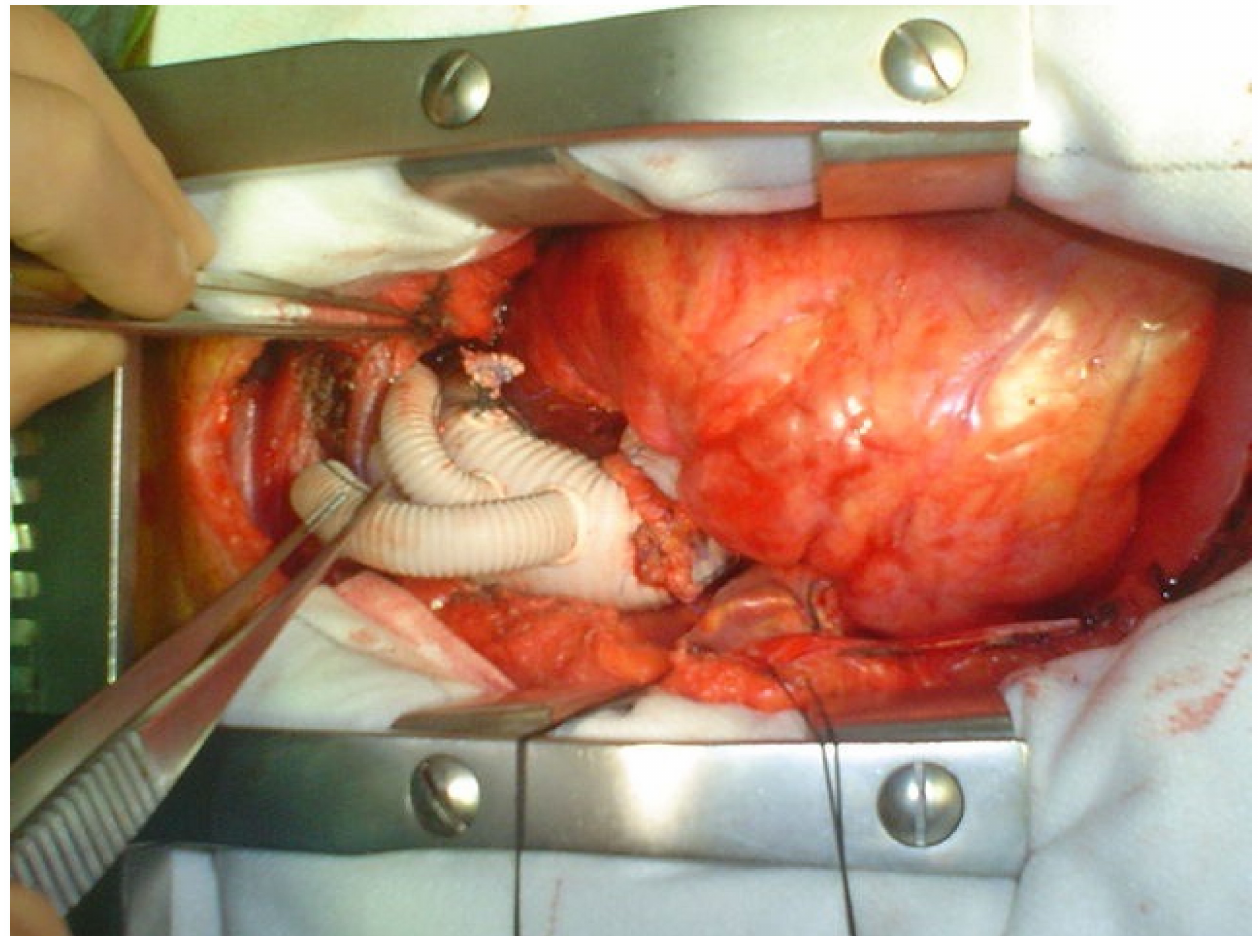
Figure 4. Type II Hybrid Repair with a dedicated branched vascular prosthesis (Plexus (Neenah, WI, USA), Vascuteck (Inchinnan,